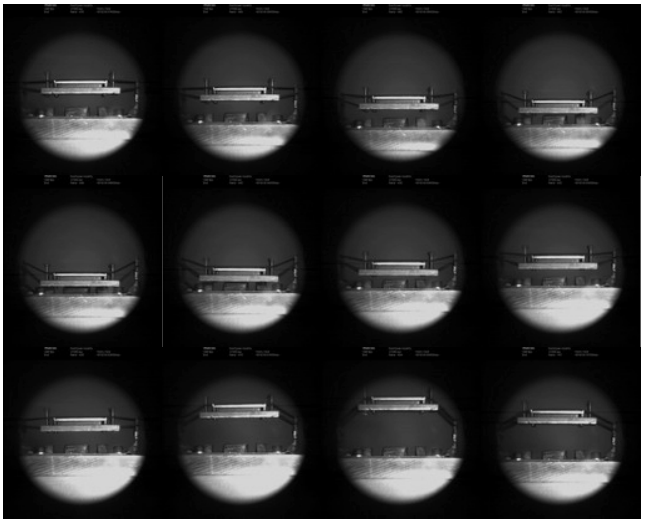
Fig. 19. Snapshots of shock response of HDD.